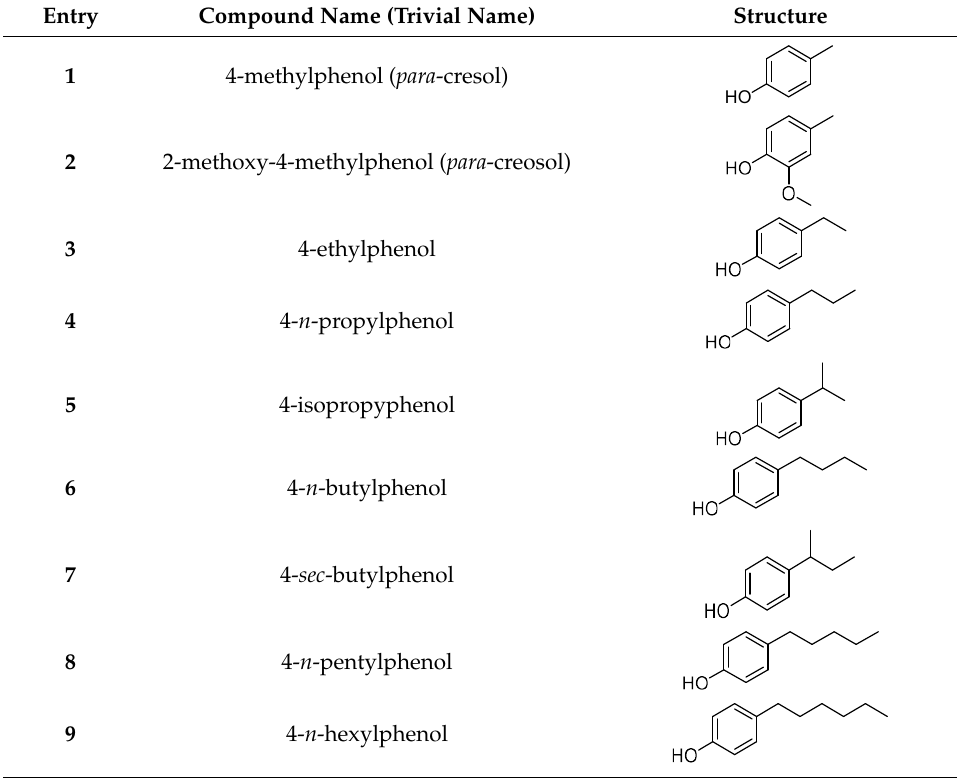
Table 3. Compounds tested in the substrate specificity screening.